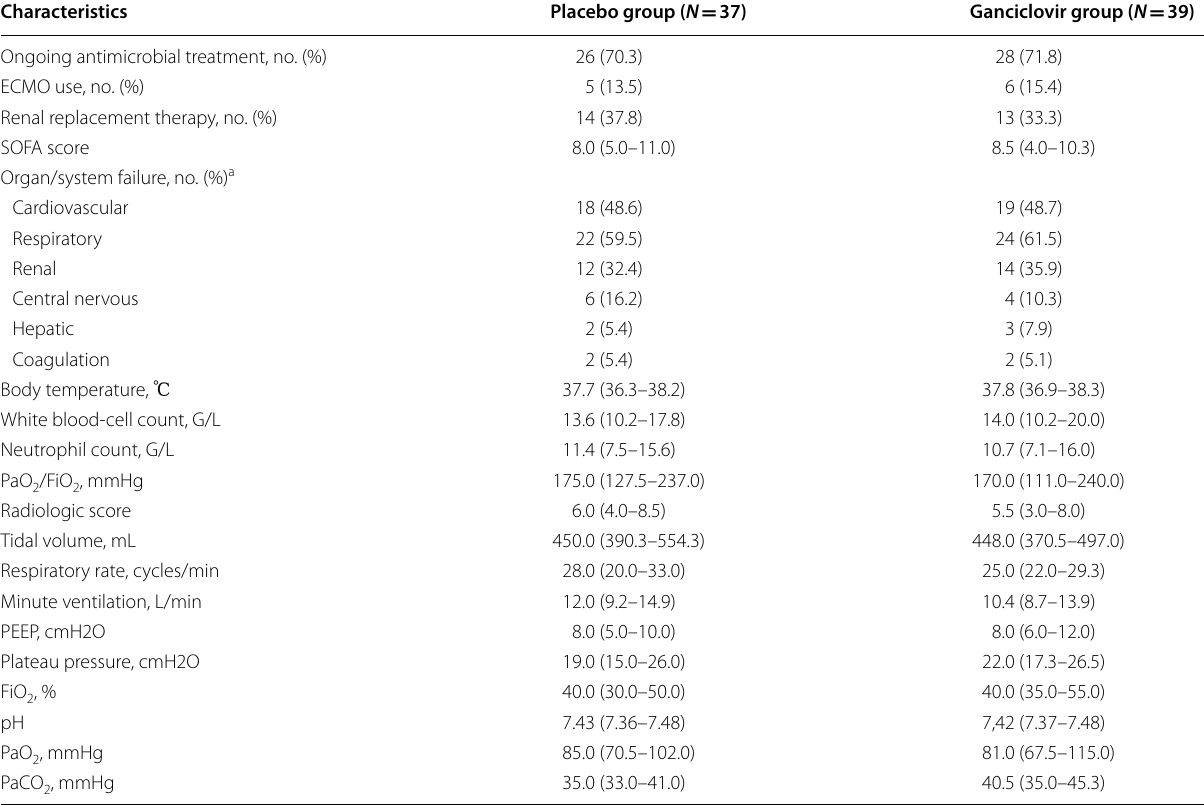
Table 2 Patient characteristics at